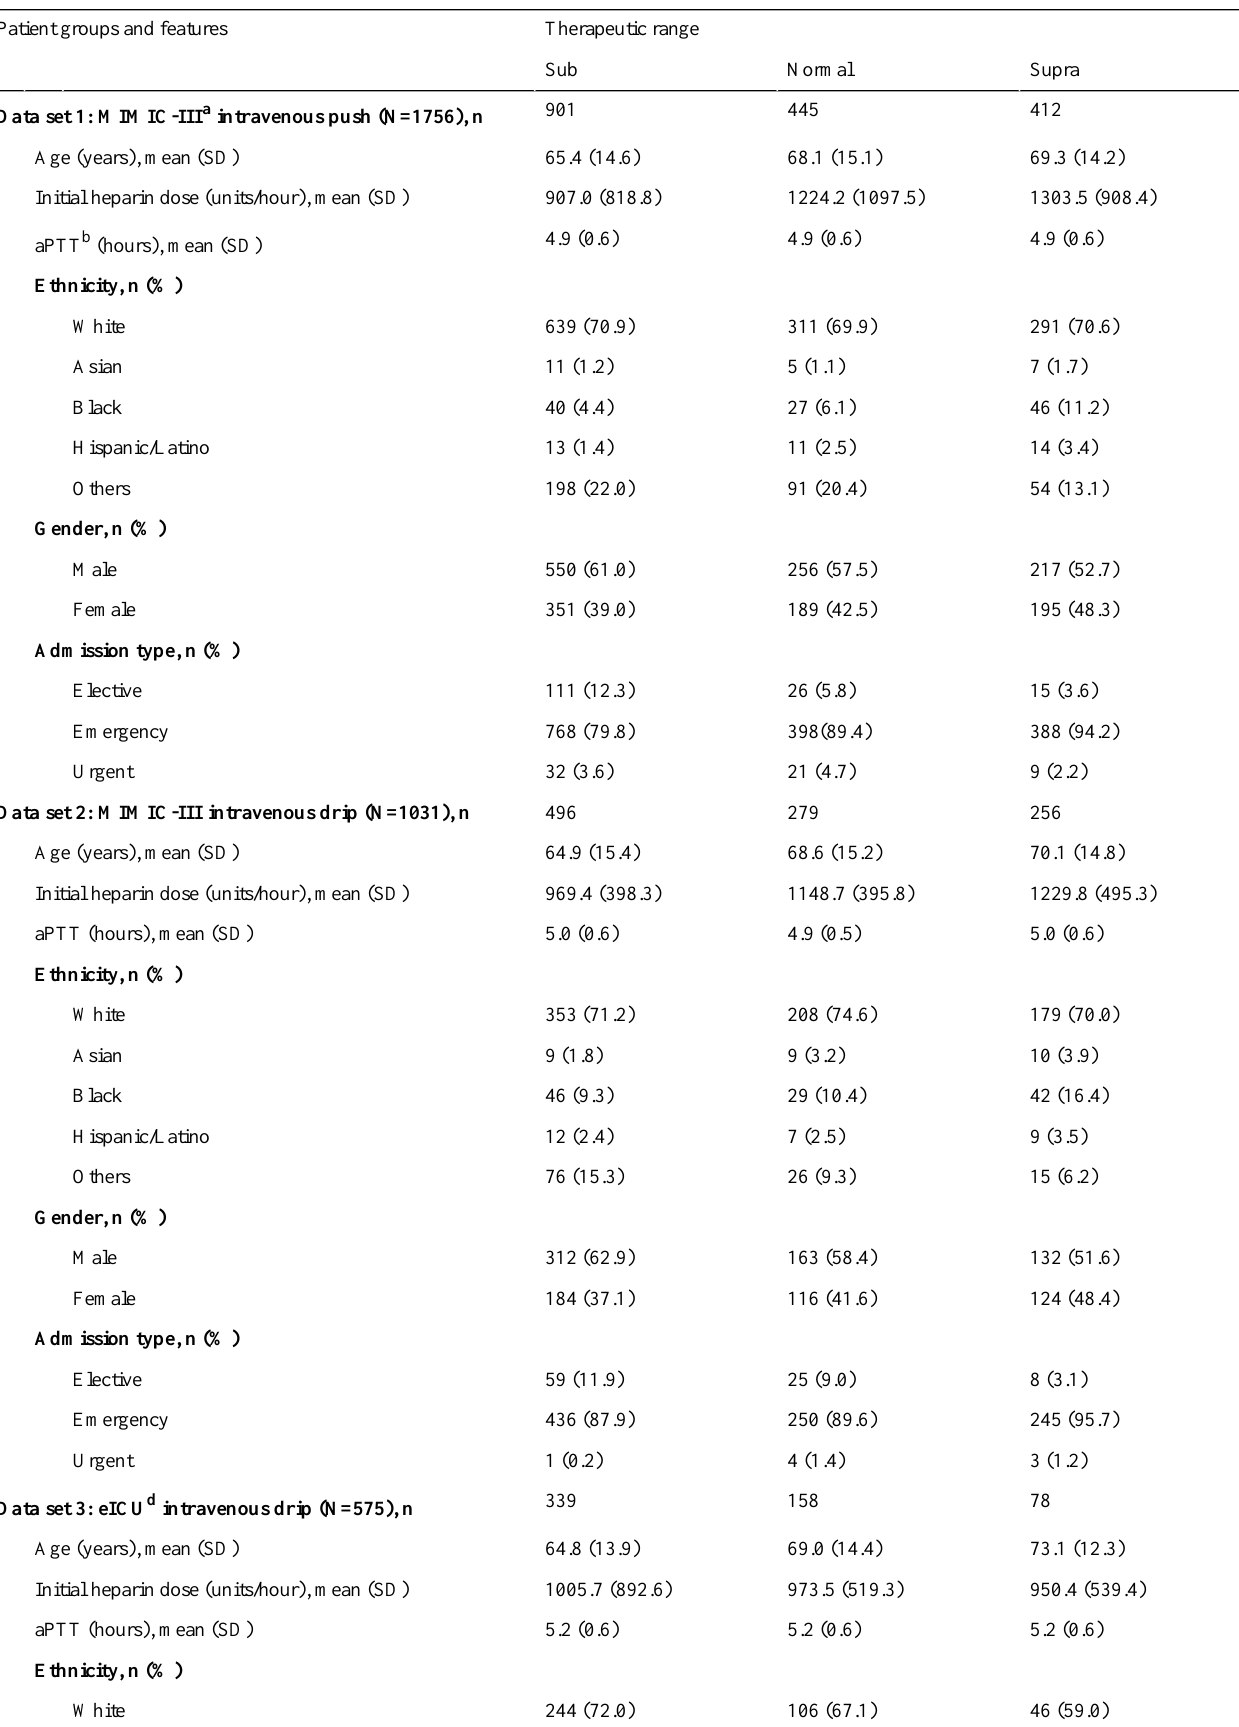
Table 1. Summary statistics of selected